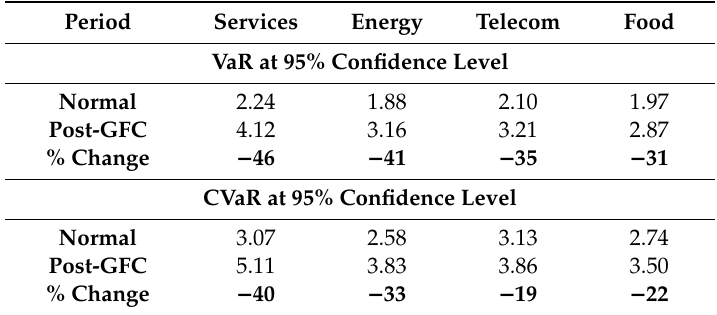
Table 5. Sub-sample VaR and CVaR of four key industries, 2009–2017.